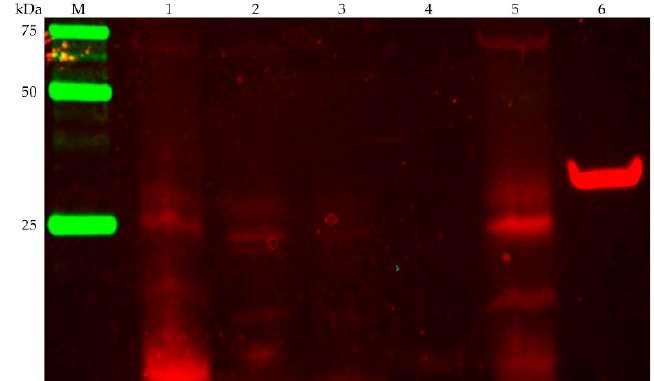
Figure 3. Detection of the membrane-bound NQR subunits NqrB and NqrC by in-gel fluorography. Cell fractions were separated by SDS-PAGE (0.15 mg protein per lane). ( M ) protein marker; ( 1 ) unbroken cells; ( 2 ) crude extract; ( 3 ) soluble fraction; ( 4 ) cleared supernatant of washed membranes after centrifugation; ( 5 ) washed membranes; ( 6 ) positive control: truncated NqrC 33-257 of the Vibrio cholerae NQR complex comprising the covalently attached FMN but lacking the N-terminal transmembrane helix.